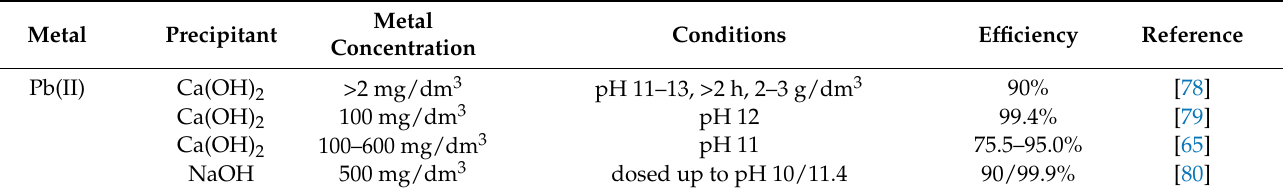
Table 11. Comparison of the Pb(II), Cd(II) and Ni(II) removal efficiency with cold plasma technology and chemical